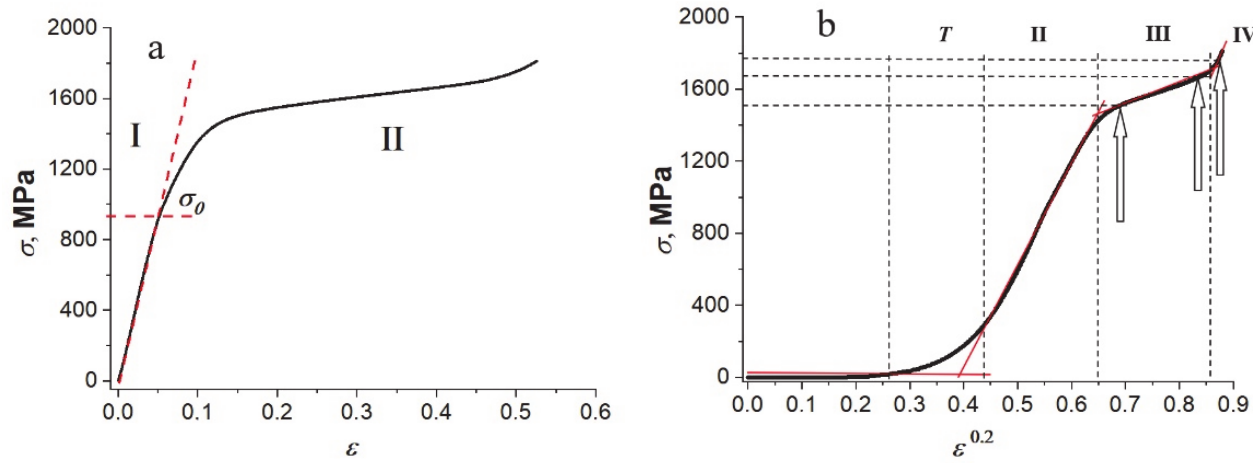
Figure 1. A stress-strain curve of rail steel in the uniaxial compression ( a ) and its treatment in coordinates σ = f ( ε 0.2 ) ( b ). The dotted lines in ( a ) indicate the elastic limit σ 0 of the material. Arrows indicate the positions of samples used for studying the structural-phase state of steel on the deformation curve.